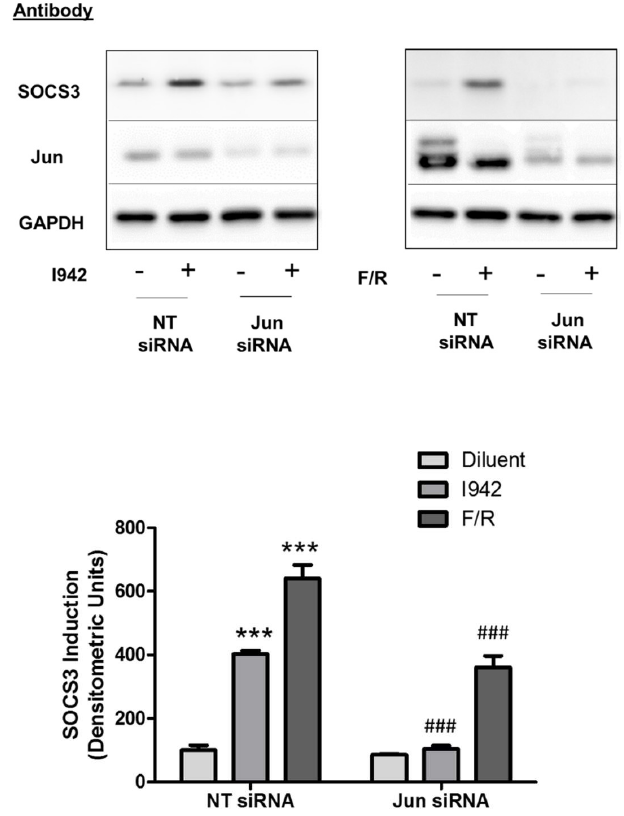
Figure 8. Confluent HUVECs were pre-incubated with siRNA to c-Jun or non-targeting siRNA (NT) for 24 h and then stimulated for 5 h in the presence or absence of 100 µ M I942 (upper left panel) or 10 µ M F / R (upper right panel). Cell extracts were then prepared and immunoblotted with antibodies to SOCS3 protein, c-Jun and GAPDH, as a loading control. Densitometry was carried out on 3 Western blots and results are shown as a bar graph. Significant increases in SOCS3 protein expression, relative to diluent-stimulated control cells, are indicated; *** p < 0.001. Significant inhibition of SOCS3 induction relative to NT siRNA-treated cells is also indicated; ### p < 0.001.